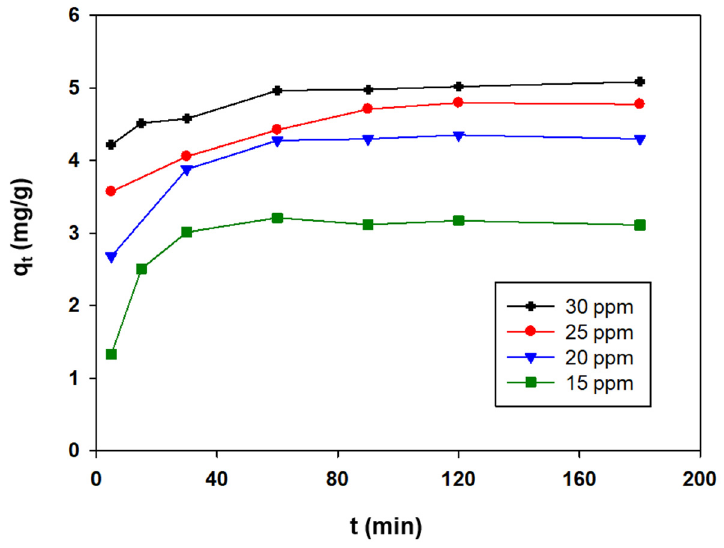
Figure 2. Influence of the initial concentration on the adsorption of 4-NPhOH on HT-DSC (experimental conditions: 25 mL of solution; 100 mg of adsorbent; 24 °C).